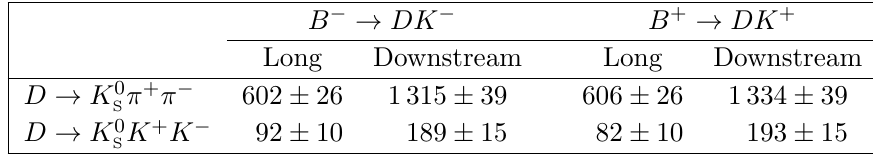
Table 2 . Fit results for the total B (cid:6) ! DK (cid:6) yields in the signal region, where the invariant mass of the B candidate is in the interval 5249{5319 MeV =c 2 , integrated over the Dalitz plots.